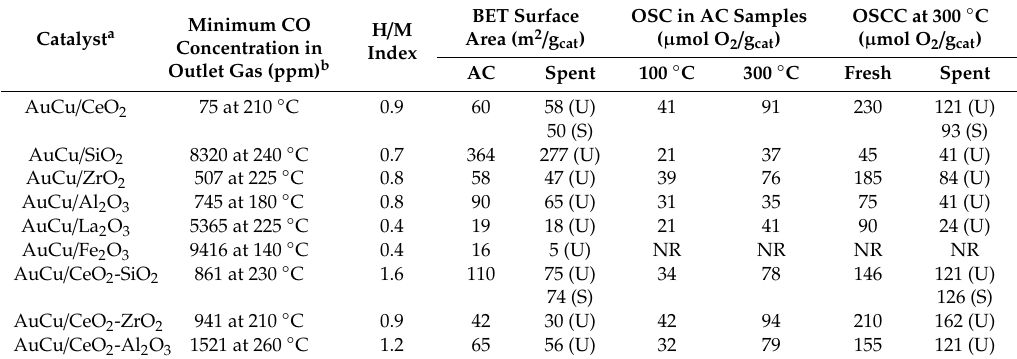
Table 1. Minimum concentration of CO obtained in syngas, apparent active metal dispersion (H / M ratio), surface area, OSC, and OSCC of Au–Cu catalysts supported on single and dual supports. Minimum CO Catalyst a Concentration